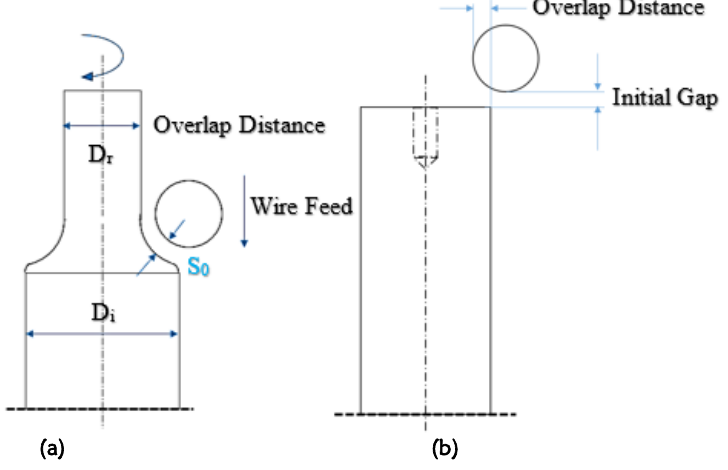
Figure 2: Various positions of wire and workpiece in WECM. (a) Initial position of workpiece and wire and (b) machining of the